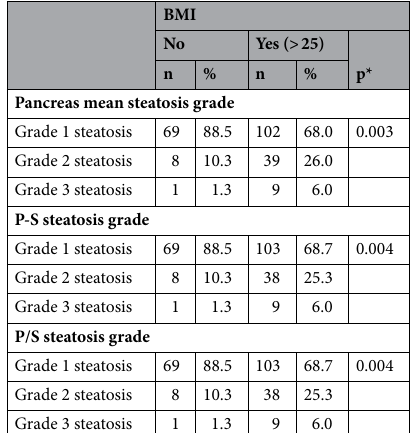
Table 2. The relationship between pancreatic steatosis and BMI in 3 different CT methods. *Spearman correlation.